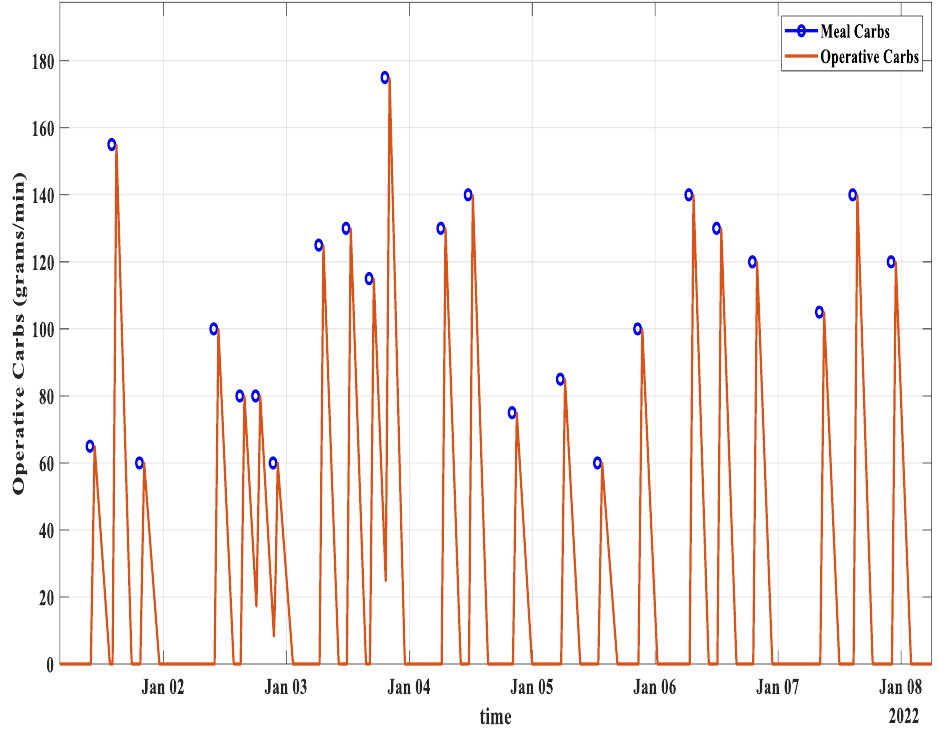
Figure 6. Meal into operative carbs transformation for data of patient ID 570. Blue circles represent the time of meal and the corresponding carbs whereas the brown curves show the transformation into operative carbs.